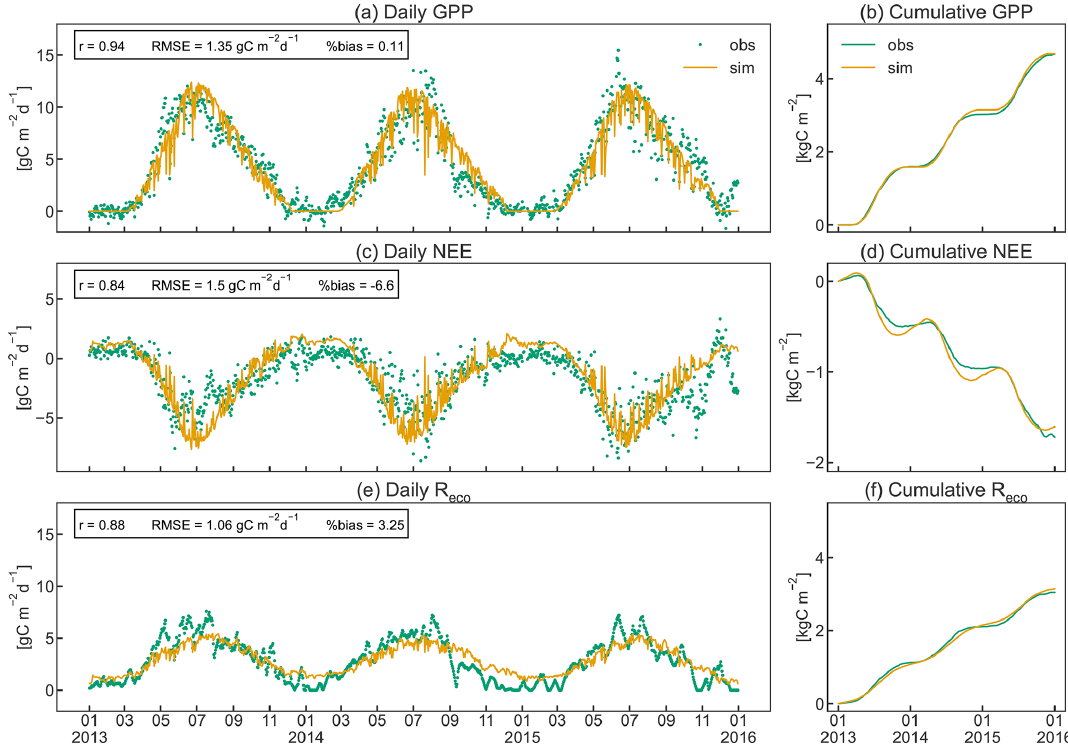
Figure 7. Daily instantaneous (a, c, e) and cumulative (b, d, f) observed and simulated fluxes of gross primary production (GPP), net ecosystem exchange (NEE), and ecosystem respiration ( R eco ) for the studied apple orchard between 2013 and 2015. Pearson’s coefficient of correlation ( r ), the root mean square error (RMSE), and the percent bias (%bias) are displayed as statistical